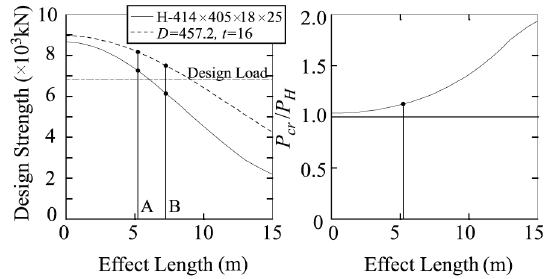
Fig. 5. Design compressive strengths: (a) comparison of section shapes and (b) the compressive capacity ratio, P cr / P